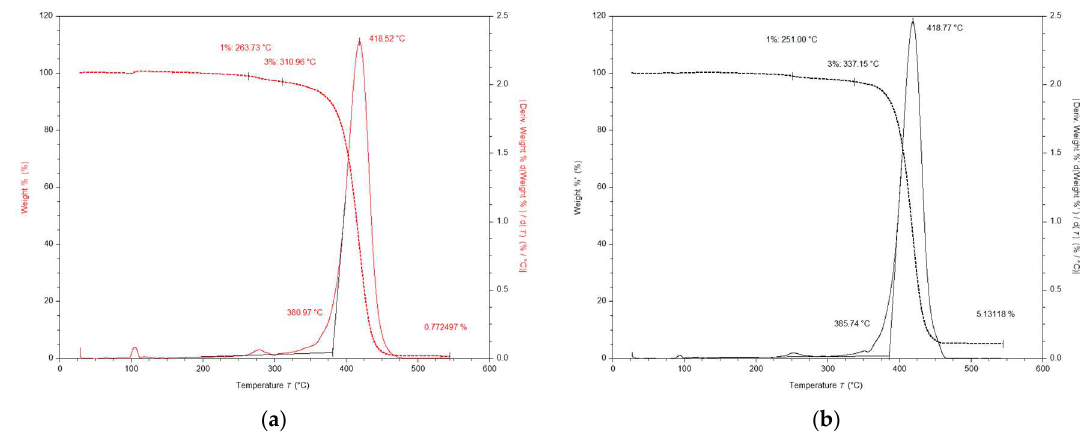
Figure 7. TGA thermograms for: ( a ) selected “white” part of the EPS B (red lines) and ( b ) the “grey” EPS C (black lines) products.